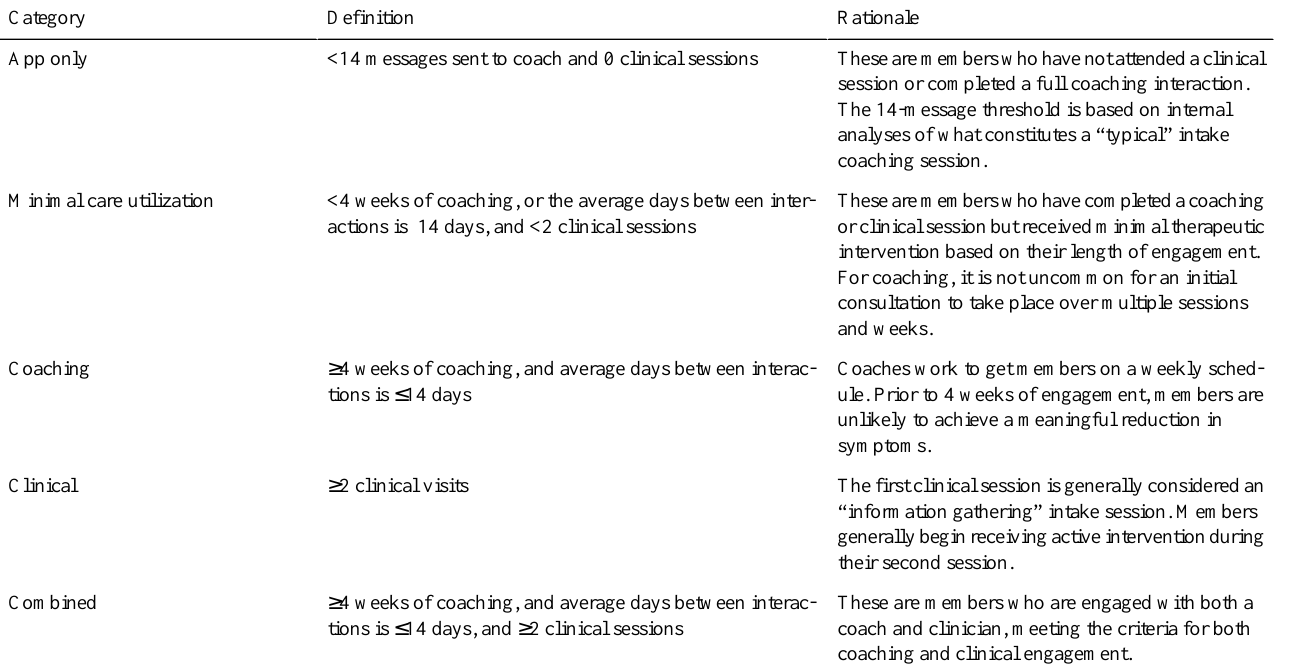
Table 1. Care modality definitions and rationale.